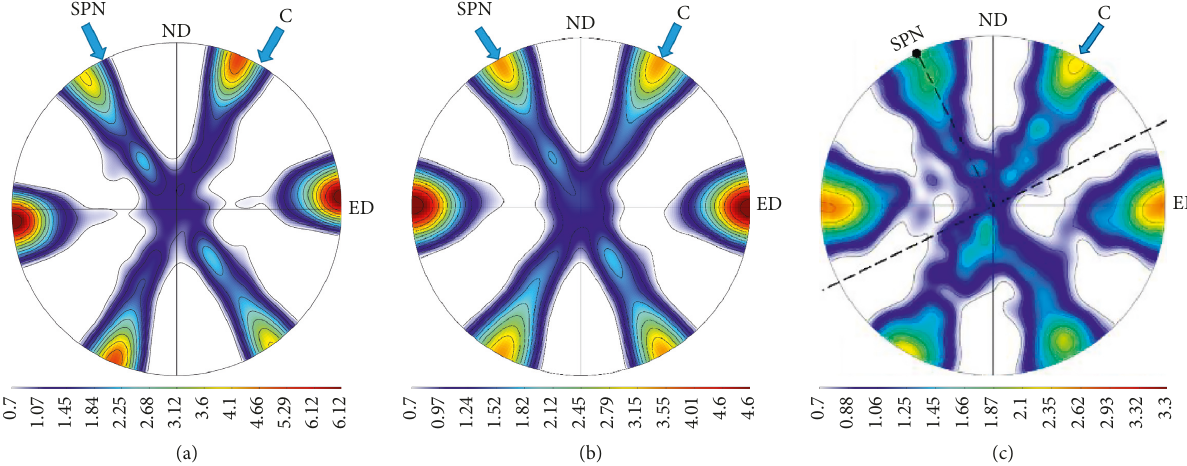
2. Circles in (c) represent the cube (cid:31)